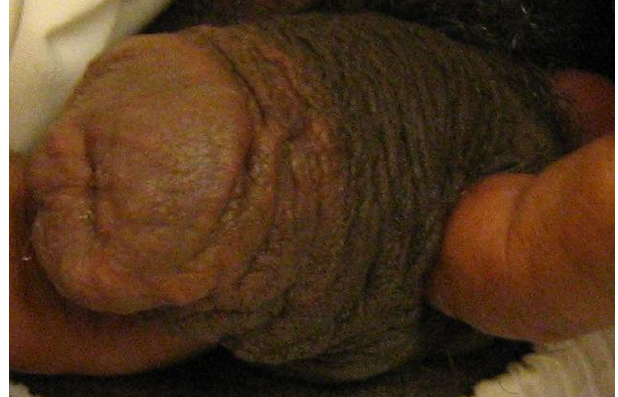
FIGURE 5 . Result after 16 weeks of conservative